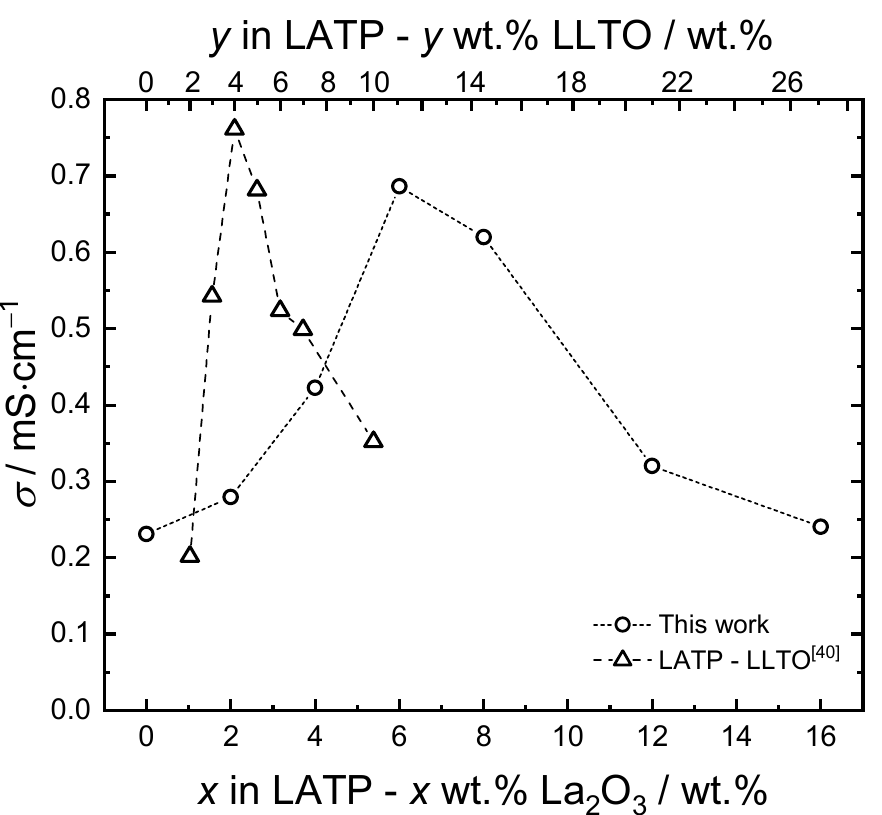
Figure 4. Room temperature conductivity of LATP–x wt.% La 2 O 3 as a function of La 2 O 3 addition, in comparison with the results in LATP–y wt.% LLTO from the previous work